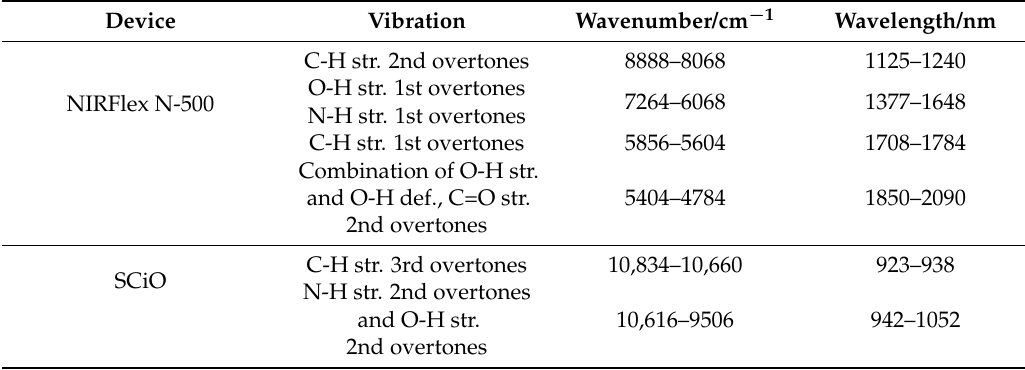
Figure 1. Averaged spectra of whole pieces of cheese of spectra recorded with SCiO (red) and NIRFlex N-500 (blue). Table 1. Important peaks and their respective vibrations in the spectra recorded with the NIRFlex N-500 and SCiO